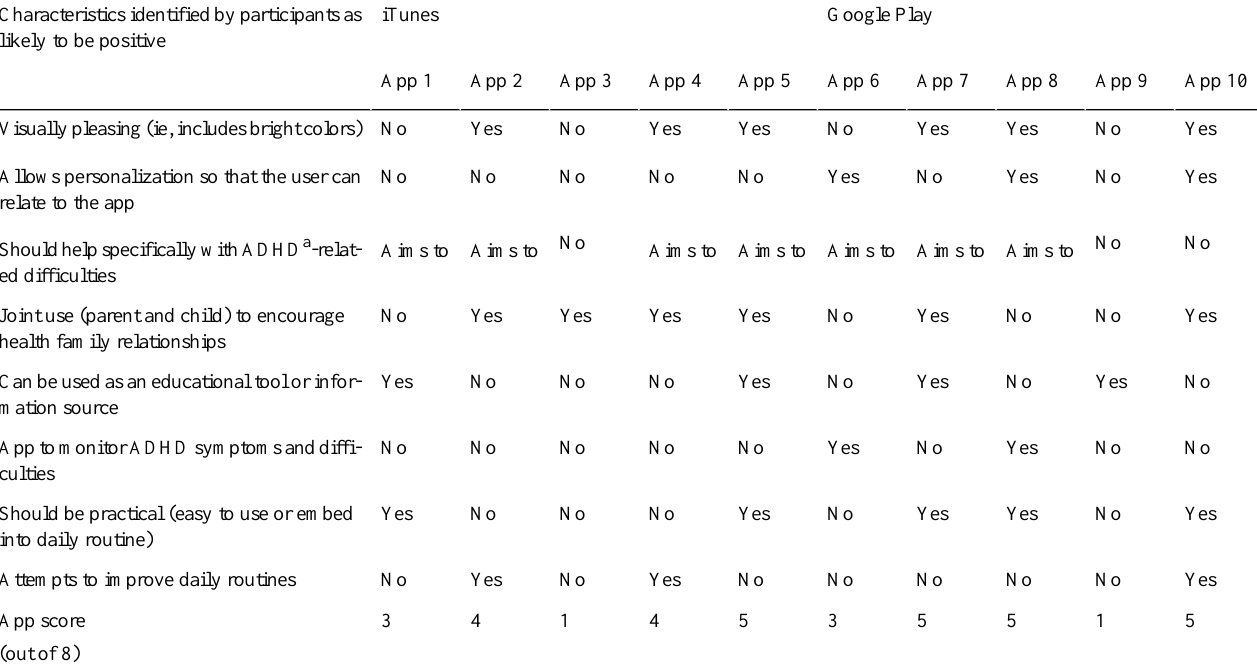
Google PlayiTunesCharacteristics identified by participants as